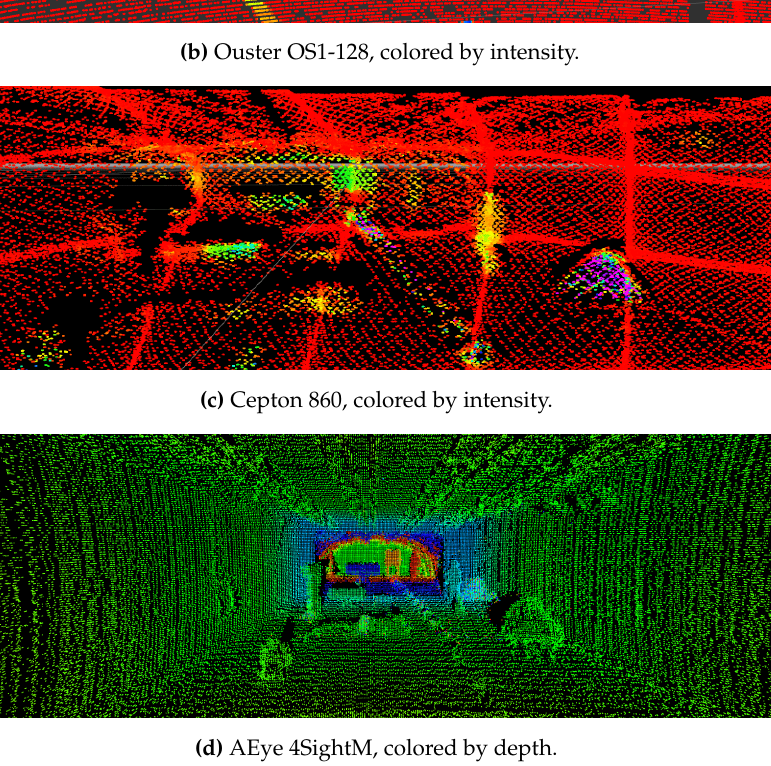
Figure 6. Captures of pointclouds taken by each